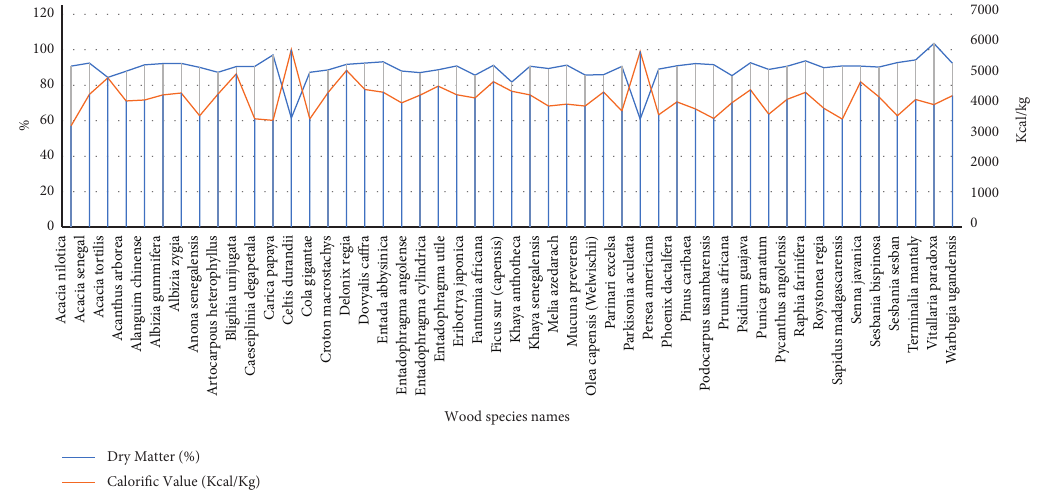
Figure 3: Calorific potential of harvested firewood by wood Table 3: Constraints in firewood and charcoal production.